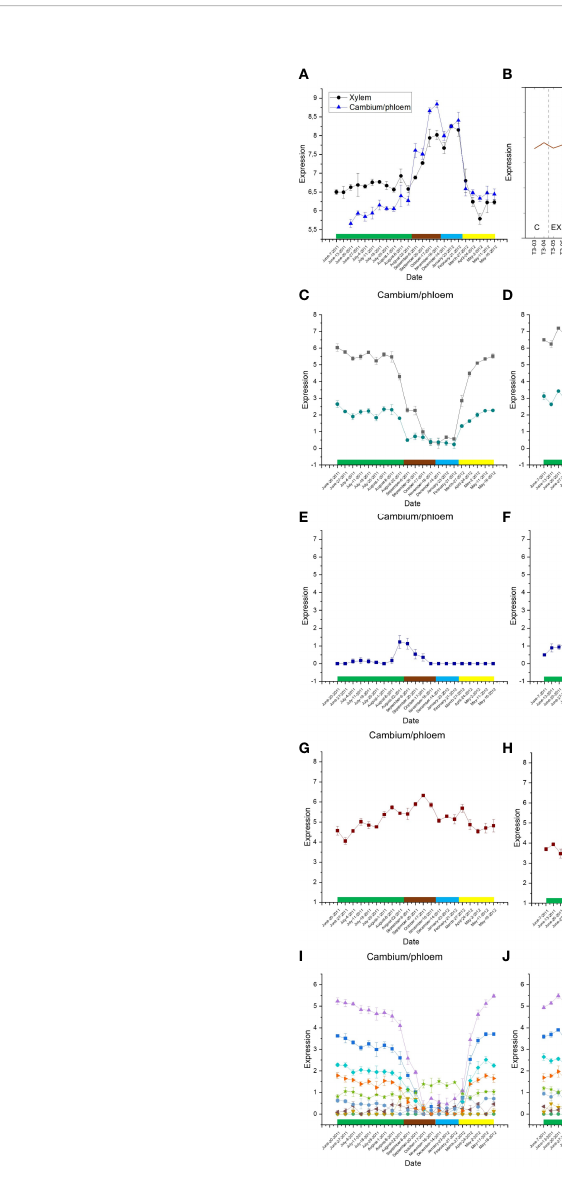
FIGURE 1 (A) Seasonal variation in the PaRBOH1 expression in xylem and in combined cambium and phloem samples (data from Jokipii-Lukkari et al., 2018). PaRBOH1 shows expression peak in late autumn and winter, and in mature xylem. Green rectangle, summer months June, July, and August; brown rectangle, autumn months September, October, and November; blue rectangle, winter months December, January, and February; and yellow rectangle, spring months March, April, and May. Values are means ± S.E. (B) Spatial expression pattern of PaRBOH1 in the tangential section series across cambial region and current year wood. The data are retrieved from the NorWood web resource (http:// NorWood.ConGenIE.org; Jokipii-Lukkari et al., 2017). The values correspond to variance stabilized gene expression. C, cambium; EX, xylem expansion; SCW, secondary cell wall formation; PCD, programmed cell death; MX, mature xylem; LW, previous year ’ s latewood. (C – J) Seasonal gene expression patterns of other Norway spruce PaRBOH genes in combined cambium and phloem samples (C, E, G, I) and in xylem (D, F, H, J); data from Jokipii-Lukkari et al.